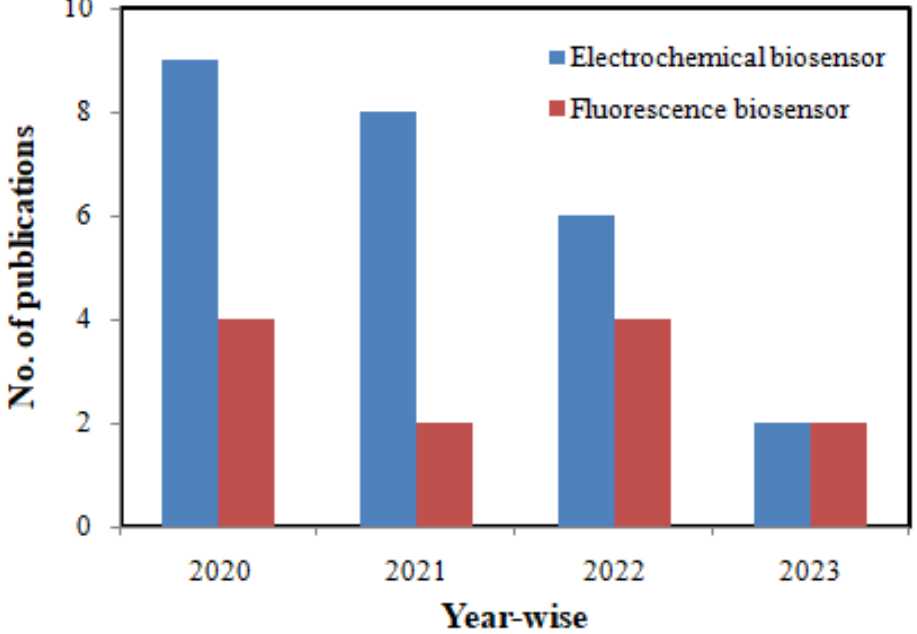
Figure 1. Year-wise development of GO/rGO-based biosensors for pesticide detection.